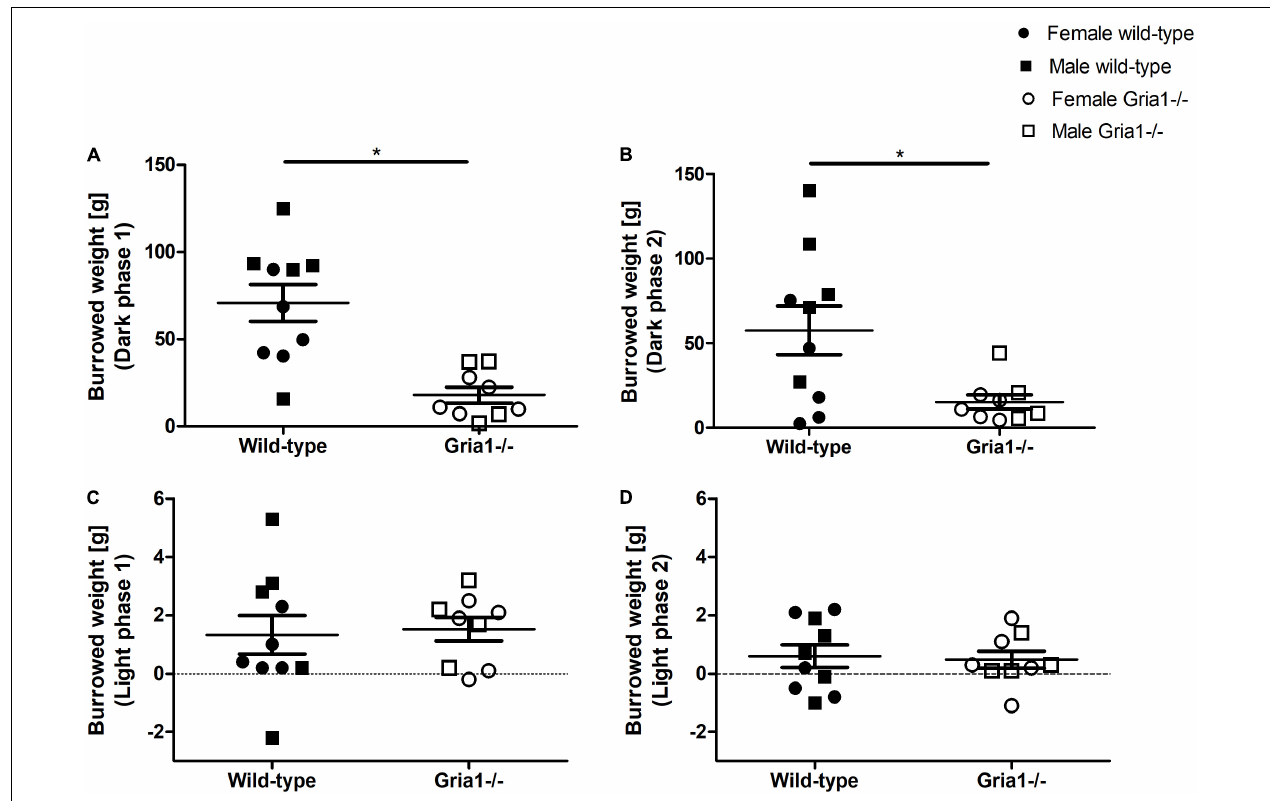
FIGURE 2 | Burrowing performance. The assessment of burrowing revealed a significant effect of genotype on the amount of burrowed pellets in the first overnight test session (A) and in the second overnight session on the consecutive day (B) . The analysis of burrowing performance during the 2-h light session showed significant group differences neither in the first test session (C) nor in the second session on the consecutive day (D) . ANOVA, followed by FDR correction. n = 4–5 per genotype per sex. * p < 0.05. Error bars indicate the standard error of the mean